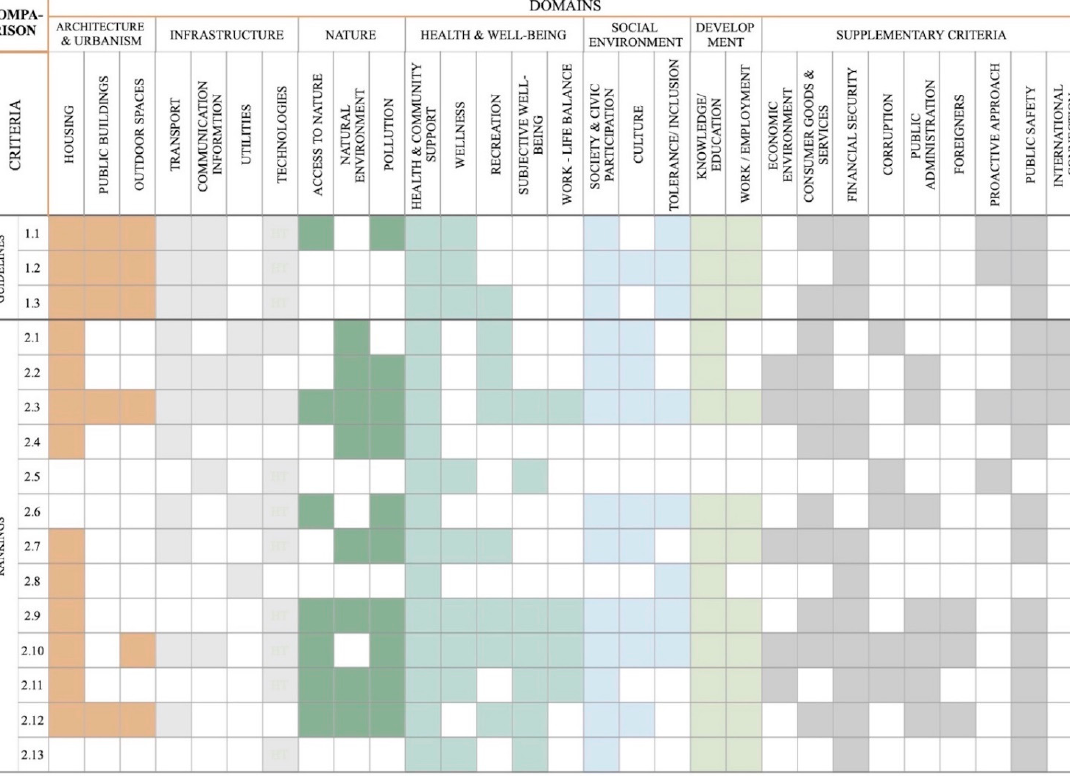
Figure 2. Share of respective criteria in the assessment: coverage